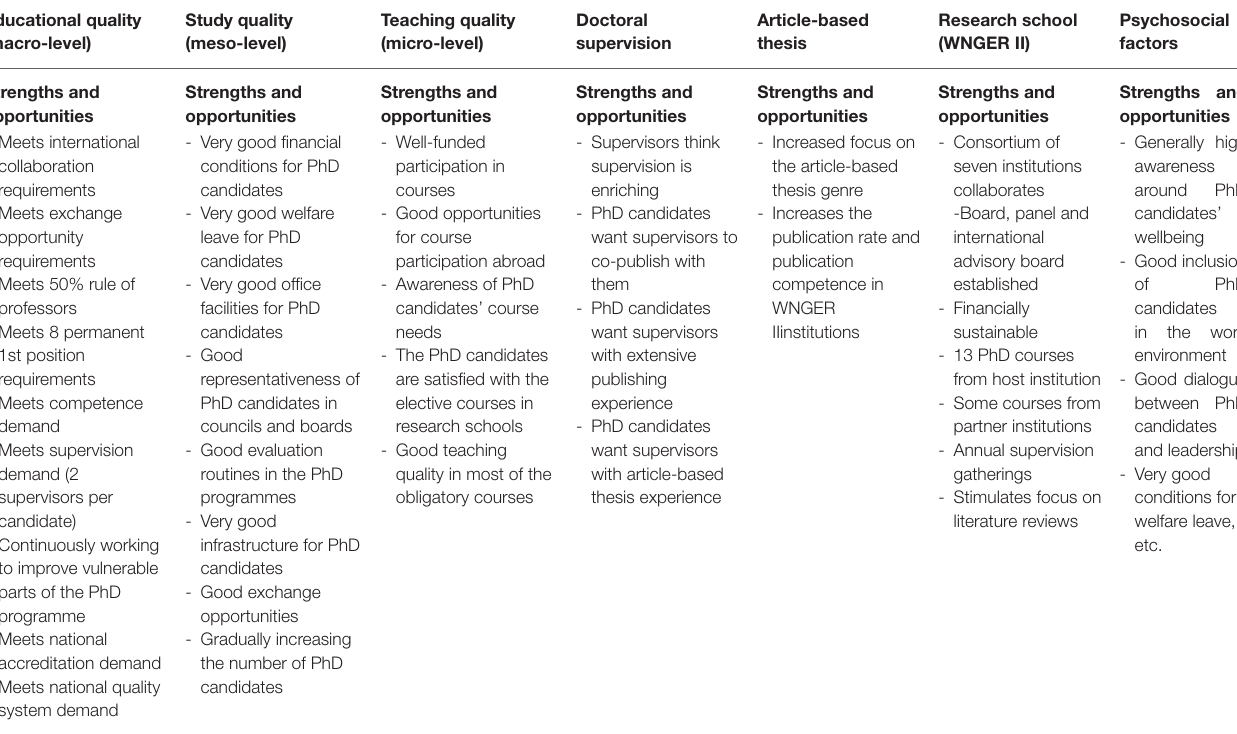
TABLE 1 | Actionable recommendations within the WNGER II consortium (strengths and opportunities) in light of the frame factors in national